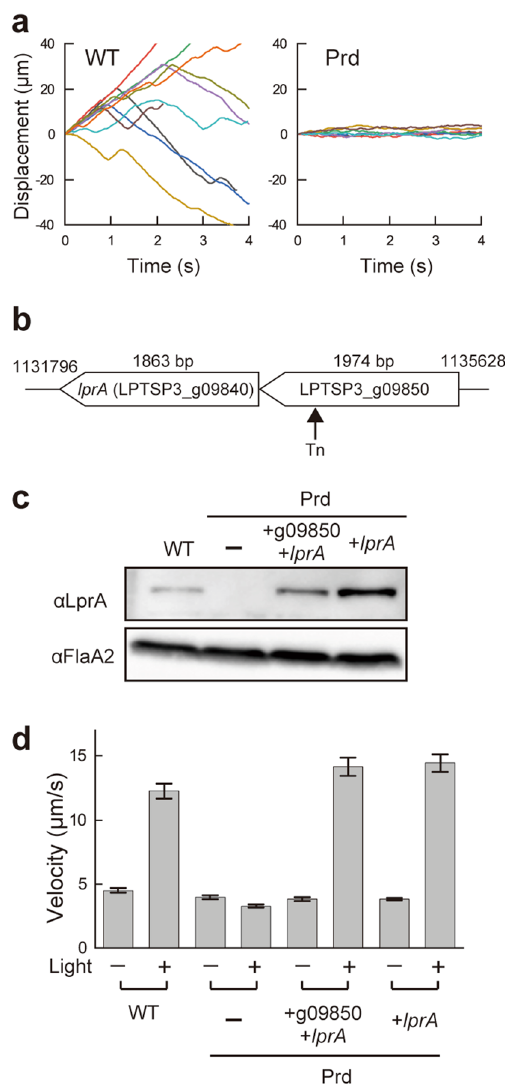
Figure 2. Identification of a photoresponsive gene in the spirochete Leptospira . ( a ) Time traces of the cell displacement under light exposure. The traces of 8 cells are shown in each strain. ( b ) Transposon insertion in the photoresponsivity-deficient mutant Prd. The position of the transposon insertion is between 1133919 and 1133920th nucleotides of the L. kobayashii chromosome 1 (DDBJ/EMBL/GenBank accession number AP025028). ( c ) Immunoblotting of whole-cell lysates from the wild-type L. kobayashii , Prd, and its complemented strains using anti-LprA and anti-FlaA2 (control) antisera. ( d ) Effect of transposon insertion and gene complementation on photoresponsivity. Swimming velocities were measured in Light OFF (−) and Light ON (+) conditions. The average values and standard errors were determined by three independent experiments (ca. 100 cells were measured in total in each